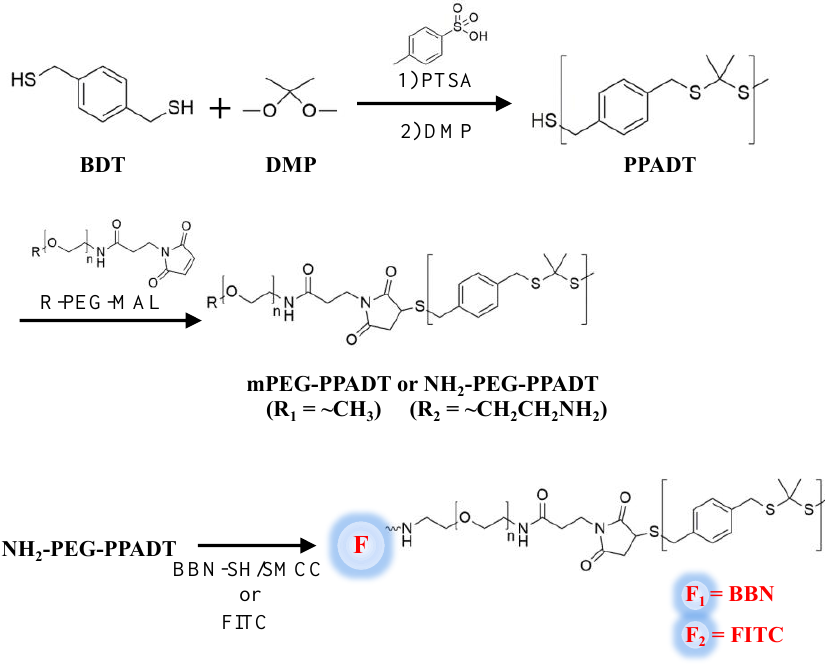
Figure 1. Synthetic scheme for mPEG-PPADT and BBN-PEG-PPADT.